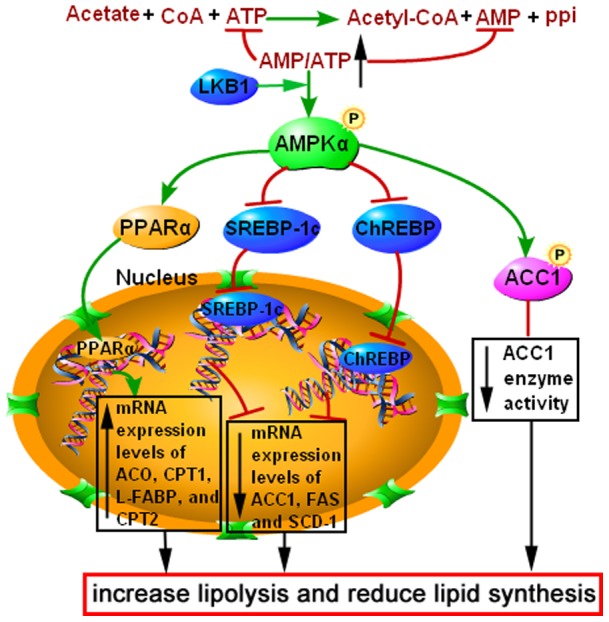
Acetic acid activates the AMP-activated protein kinase signaling pathway to regulate lipid metabolism in bovine hepatocytes.Acetic acid is metabolized to acetyl-CoA with consumption of ATP in bovine hepatocytes, resulting in a significant elevation of the AMP/ATP ratio and the phosphorylation and activation of AMPKα. Activated AMPKα increases the expression and transcriptional activity of PPARα, thereby increasing the expression of lipolytic genes, including ACO, CPT1, CPT2, and L-FABP. AMPKα activation inhibits the expression and transcriptional activity of SREBP-1c and ChREBP, thereby reducing the expression of lipogenic genes, including ACC1, FAS, and SCD-1. In addition, activated AMPKα directly phosphorylates and inhibits ACC1. Consequently, acetic acid increases lipolysis and reduces lipid synthesis in bovine hepatocytes.